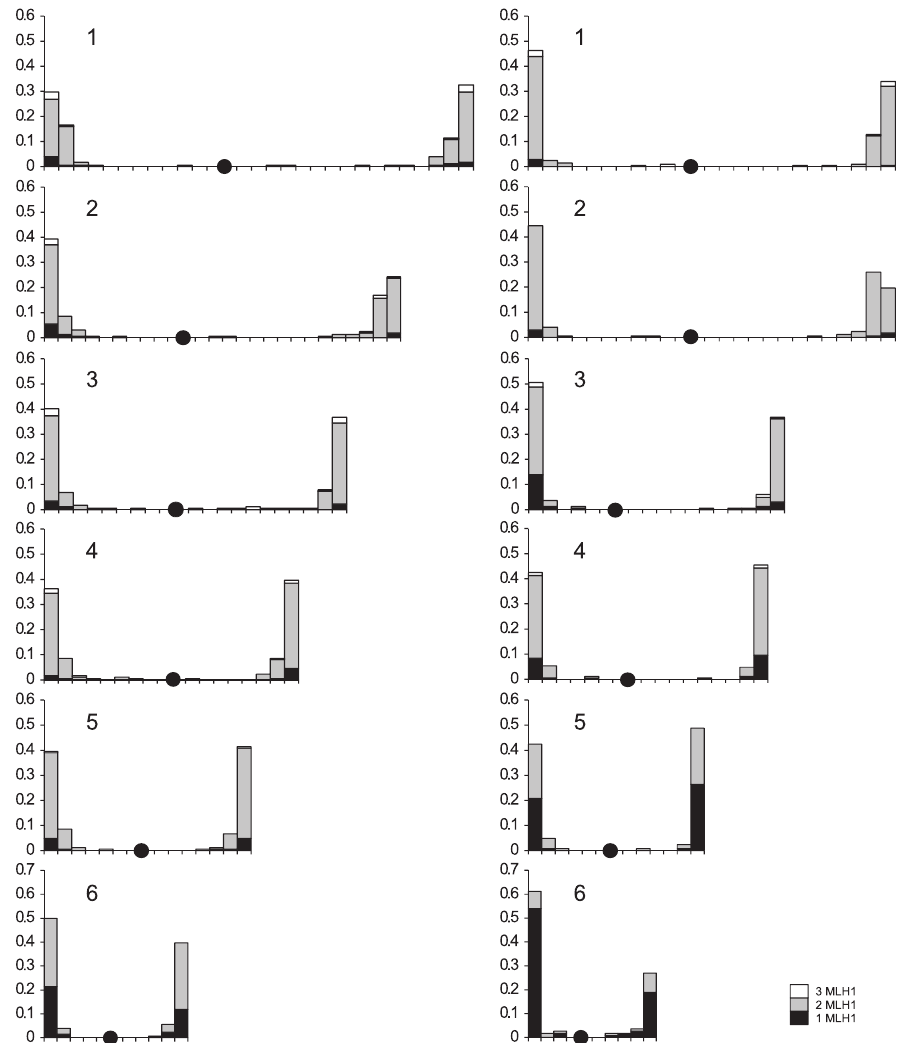
Figure 2. The distribution of MLH1 foci along the macrochromosomes of A. carolinensis and D. coelestinus. The X-axis shows the position of MLH1 foci, the marks on this axis are separated by 1 µm. Black dots indi- cate centromeres. The Y-axis indicates the frequency of MLH1 foci in each 1 µm – interval. Stacked columns show the frequency for the SCs containing MLH1 foci at each